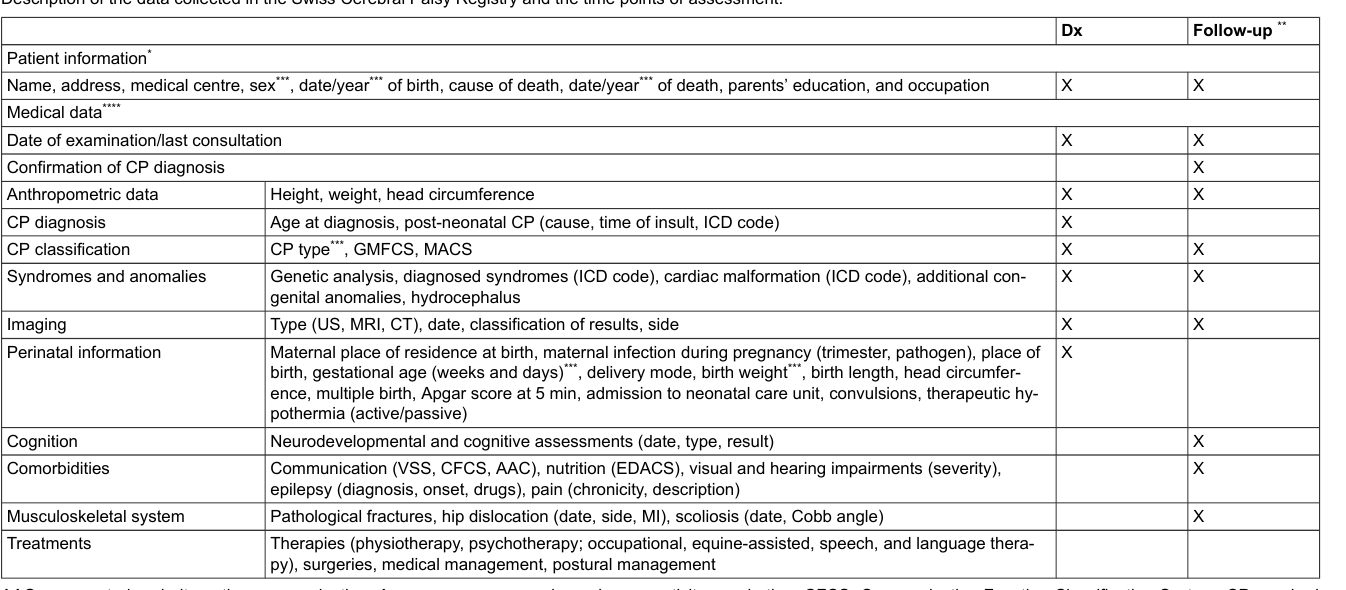
Table 1: Description of the data collected in the Swiss Cerebral Palsy Registry and the time points of assessment.